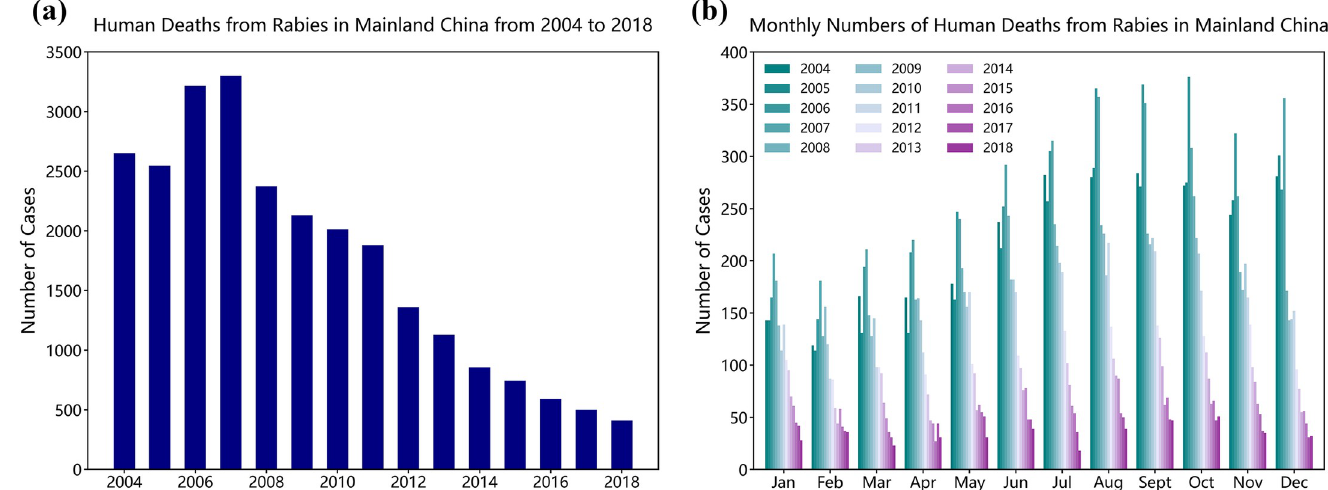
Fig 2. Time series of human deaths from rabies in mainland China. (a) Annual human deaths from rabies in mainland China ranging from 2014 to 2018. (b) Seasonal pattern of human deaths from rabies in mainland China.